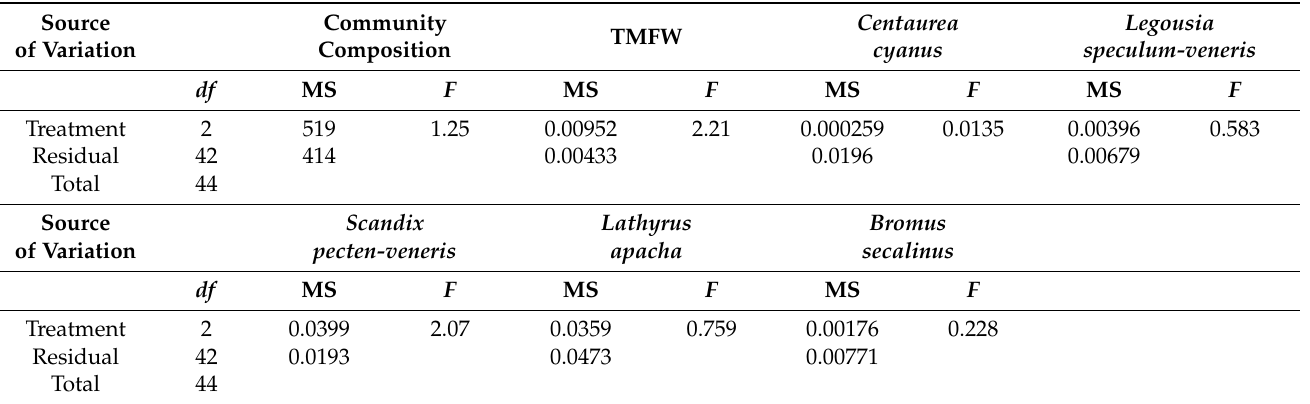
Table 8. Results of the PERMANOVA analyses on community composition with the mean fresh weight of each species as an abundance measure, on the total mean fresh weight per pot (TMFW), and on the mean fresh weight of single species per